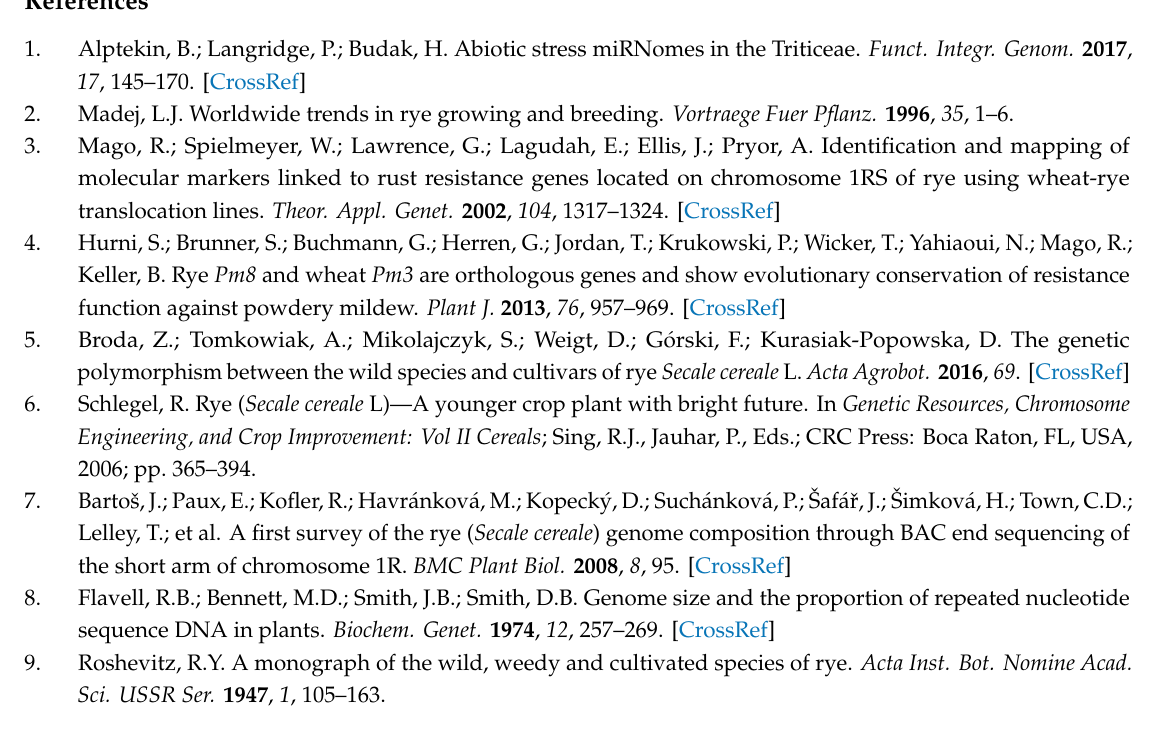
Table S1, The list of species, along with the accession numbers for each sample. Table S2, General description of standard SPInDel profiles from the atpB-rbcL cpDNA region. Table S3, General description of standard SPInDel profiles from the trnT (UGU)- trnL (UAA)5 (cid:48) exon cpDNA region. Table S4, General description of standard SPInDel profiles from the trnL (UAA) intron cpDNA region. Table S5, General description of standard SPInDel profiles from the trnD [tRNA-Asp(GUC)]- trnT [tRNA-Thr(GGU)] cpDNA region. Table S6, General description of standard SPInDel profiles from the nad1 exon B- nad1 exon C intron mtDNA region. Table S7, General description of standard SPInDel profiles from the nad4 / 1-2 mtDNA region. Table S8, General description of standard SPInDel profiles from the nad4L-orf25 mtDNA region. Table S9, General description of standard SPInDel profiles from the rps12-1 / nad3-2 mtDNA region. Table S10, General description of standard SPInDel profiles from the rps12-2 / nad3-1 mtDNA region. Table S11, General description of standard SPInDel profiles from the rrn5 / rrn18-1 mtDNA